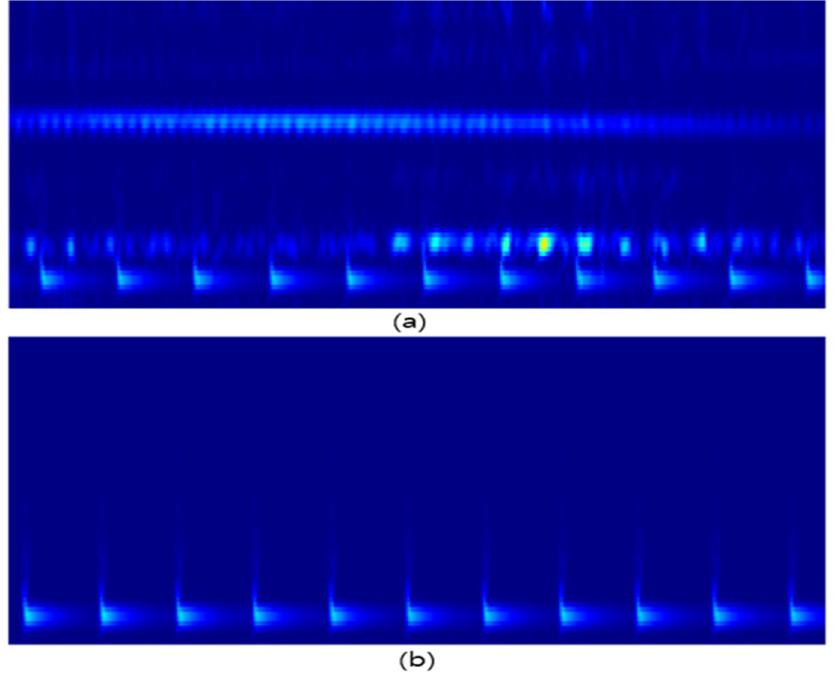
Figure 23. STFT of the signal overlapped on the noise signal [( a ): with noise, ( b ): without noise]. Therefore, as a result of minimizing the influence of the noise signal by cropping only the frequency band indicated by the flats, it was confirmed that only a slight difference appears in the red square shown in Figure 24.